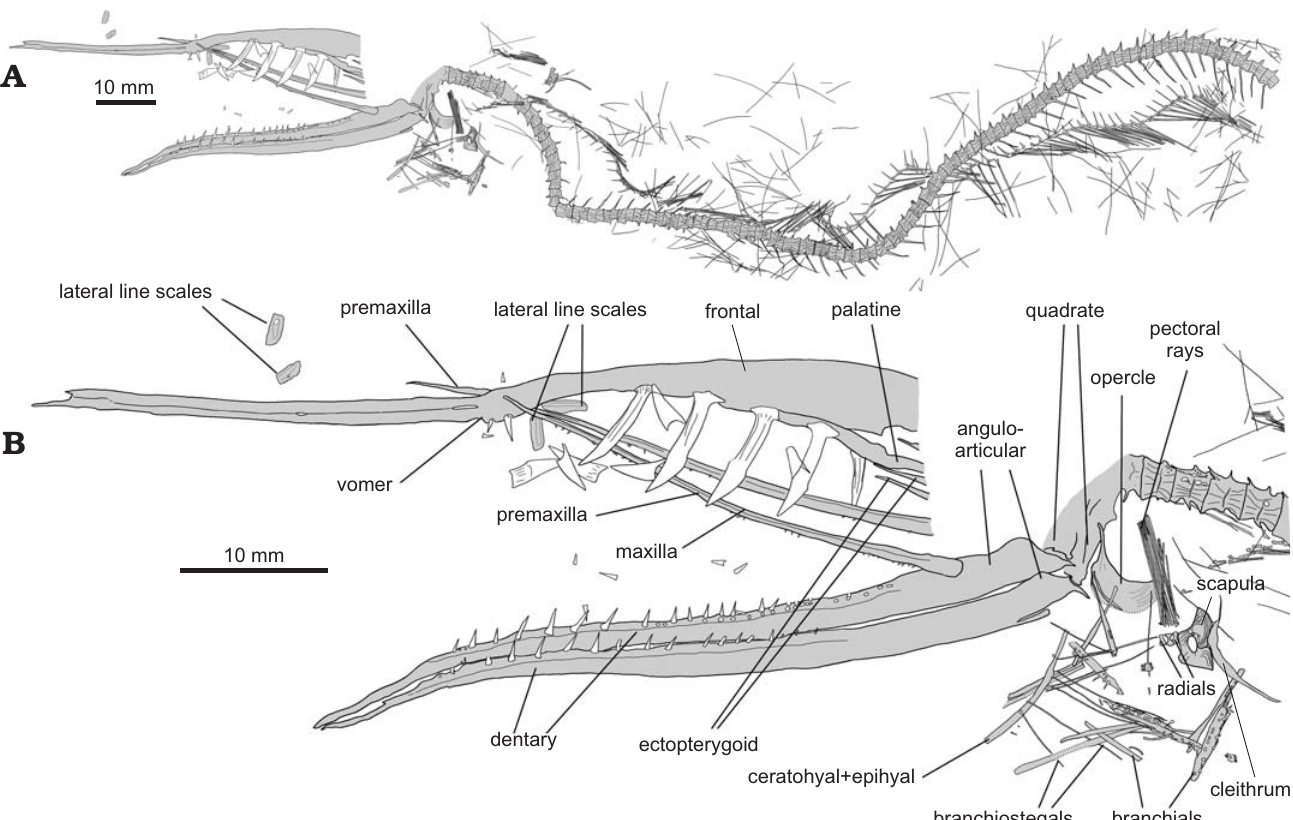
Fig. 4. Alepisauroid fish Polymerichthys sp. from Sakhalin Island, Kurasi Formation, Middle–Late Miocene, ZIN 314p, outline drawing of specimen ( A ) and skull ( B